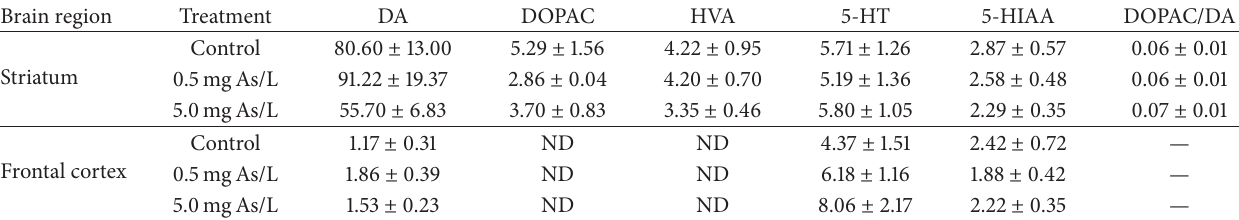
Table 4: Regional brain content of monoamines (ng/mg protein) in striatum and frontal cortex of mice exposed to 0.5 or 5.0 mg As/L of drinking water for six months.